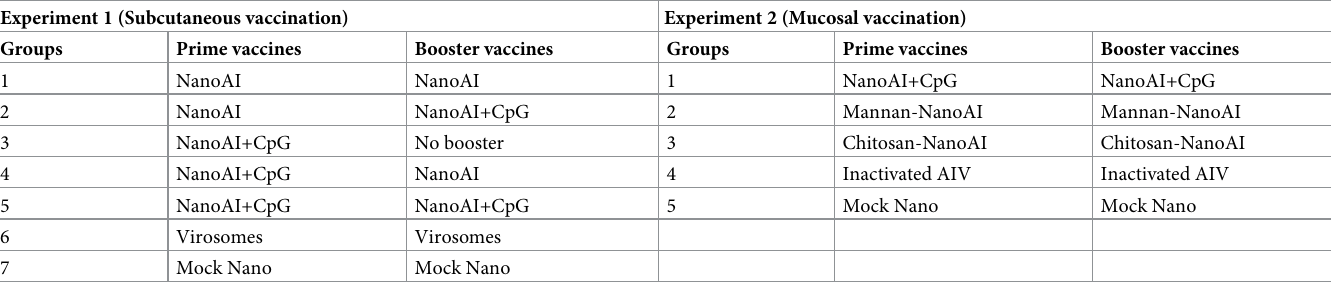
Table 1. Study design showing experimental groups and vaccination protocols. Experiment 1 (Subcutaneous vaccination) Experiment 2 (Mucosal vaccination)